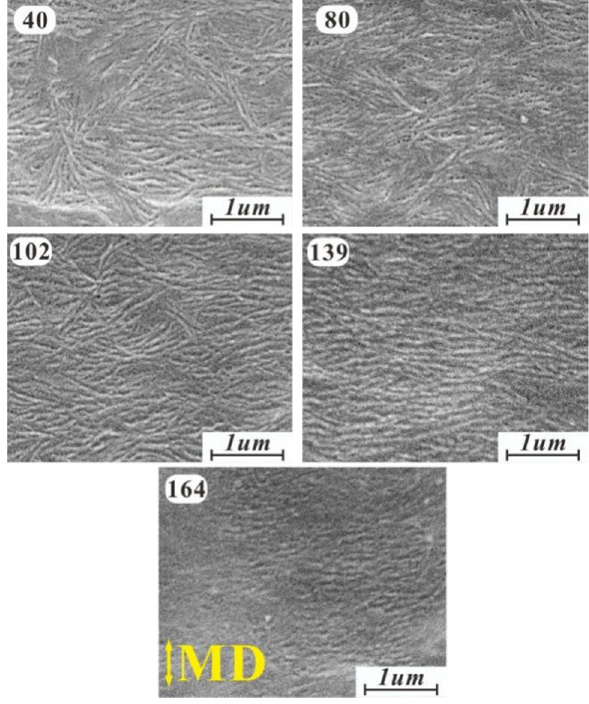
Figure 1: SEM of etched PMP fi lms prepared at di ff erent MDRs.